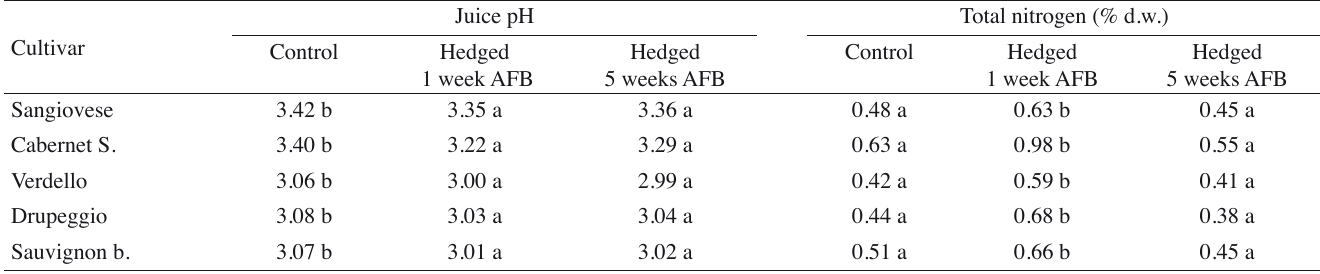
Table 7 - Juice pH and berry nitrogen content at harvest in vines of different grapevine cultivars hedged one and five weeks after full bloom (AFB) and